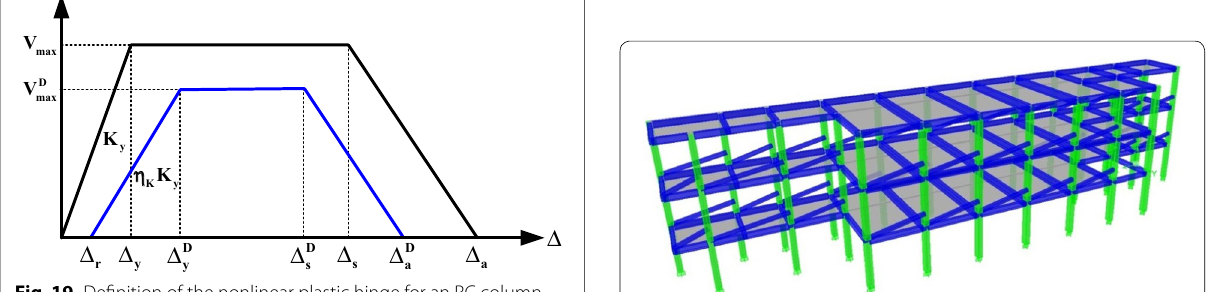
Fig. 19 Definition of the nonlinear plastic hinge for an RC column member. Fig. 20 The finite element model of the selected RC school